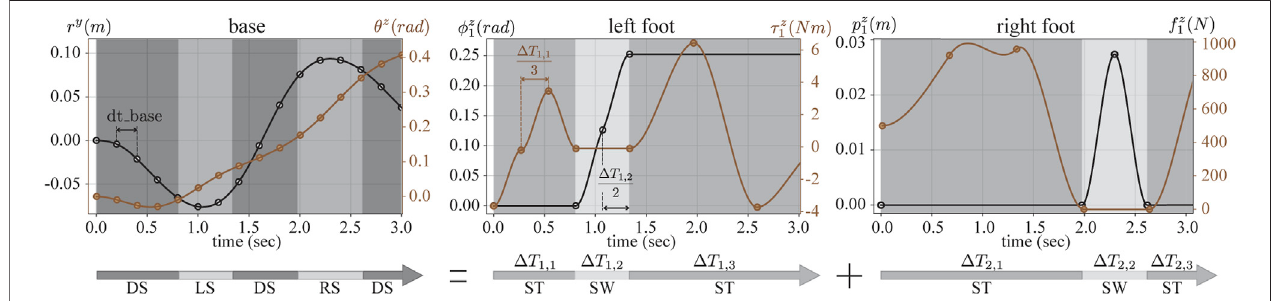
FIGURE 3 | Spline trajectories for various processes are illustrated. The optimization nodes are represented by dots and the associated slopes at these positions. Cubic Hermite polynomials connect two consecutive nodes and de fi ne spline trajectories. The process trajectories are parameterized by their boundary values at the collocation nodes along their interval durations. The base motion trajectories are discretized with a fi xed timestep dt_base, whereas the feet trajectories and contact wrenches are discretized with a fi xed number of polynomials per phase (two for the swing trajectory, and three for the stance wrenches), whose duration is also an optimization variable. Below, three timing variables per foot are shown, where ST and SW stand for the stance and swing phase. The combination of feet phases determinethegaitsequenceandschedules,whereDS,LS,andRSstandfordoublesupportphase,leftfootswingphase,andrightfootswingphase,respectively.Note that TOWR+ optimizes 6 dimensional motions ( p i , ϕ i ) and wrenches ( f t , τ i ) for each end-effector, but only few variables are illustrated